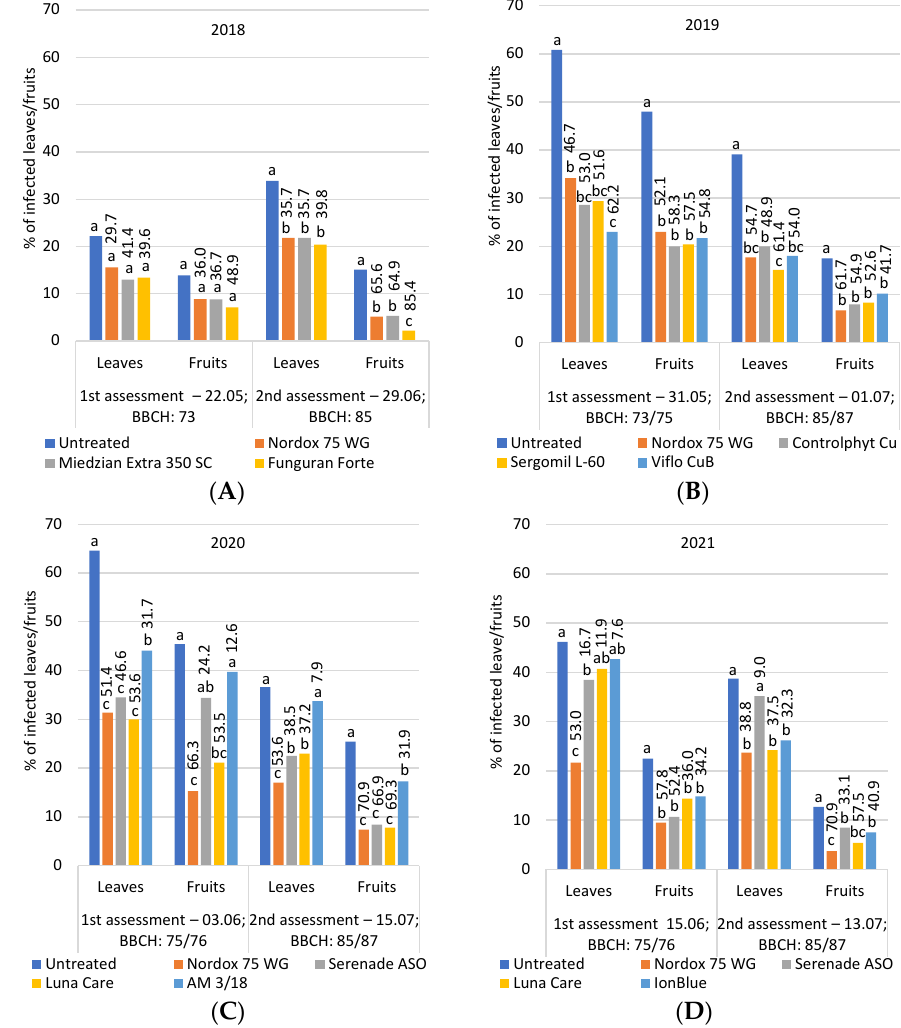
Figure 2. ( A – D ). Incidence of infection by bacterial canker (caused by P. syringae ) on leaves and fruits of sour cherry after foliar applications of different products during the flowering period in 2018–2021. Efficacy values are shown above each bar. The means marked by the same letter do not differ according to the Newman‒Keuls test at the 5% significance level.